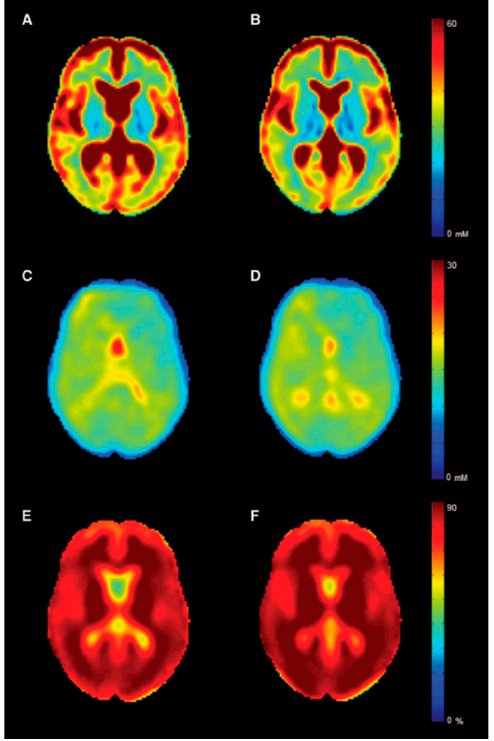
Figure 6. Sodium maps. Mean sodium MRI maps for multiple sclerosis patients (left column) and controls (right column). In the first row is displayed the total sodium concentration ( A , B ), while in the middle and last rows, the intracellular sodium concentration ( C , D ) and the intracellular sodium volume fraction (indirect measure of extracellular sodium concentration) ( E , F ) are shown. Reprinted from Brain , Vol. 139, Issue 3, P 795–806, 20 January 2016 [167]. Copyright: © 2021] with permission from Oxford University Press.